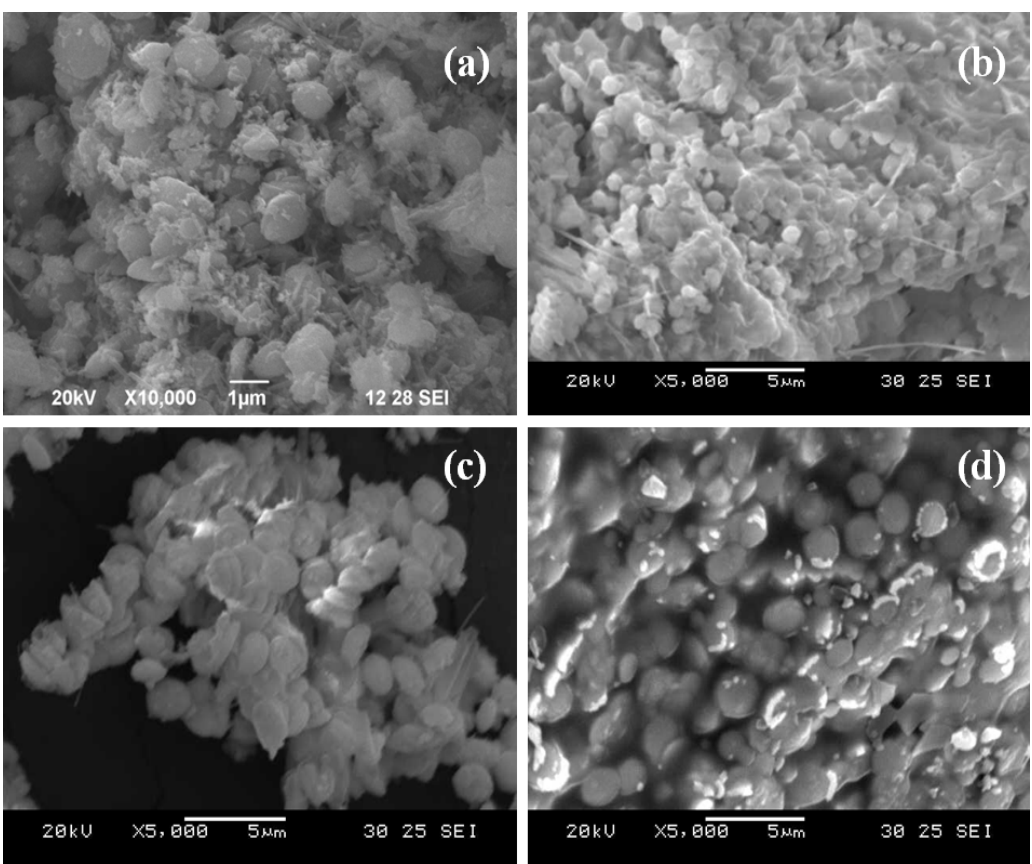
Fig. 6. SEM image of (a) ZnO; (b) Cu-ZnO; (c) Co-ZnO and (d) (Co,